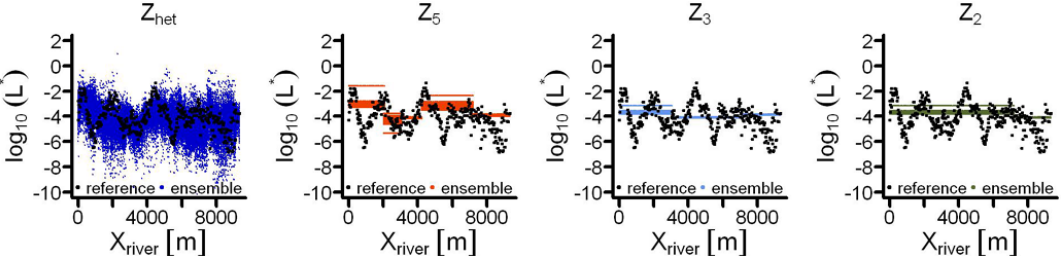
Fig. 11. Ensembles of leakage coefficients (coloured) and reference field (black) along the river reach at day 600 for scenario A when only 10 observation points are available. Distance X river is calculated starting from the two most western river nodes. L ∗ has units m s − 1 .